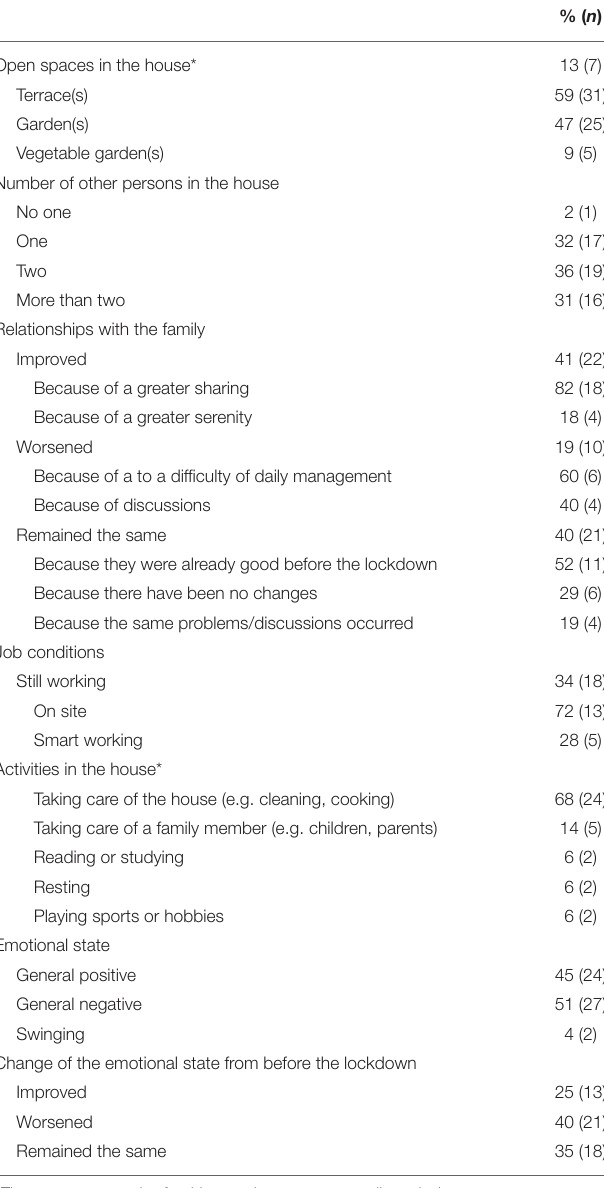
TABLE 4 | Prevalence of physical and psychological symptoms of the SRT and perception about their changes from pre-lockdown period among the disordered gamblers’ affected family